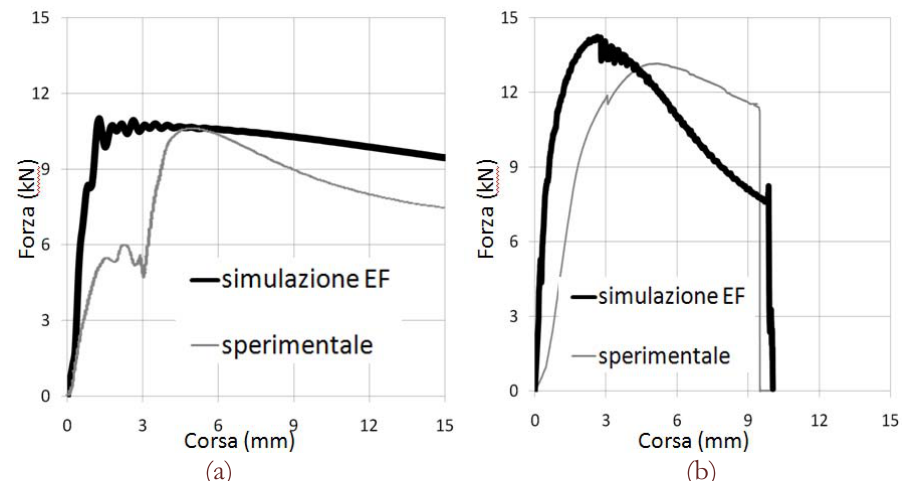
Figura 5: Confronto numerico-sperimentale tubo incollato lato 25mm (a) e lato 40mm (b).